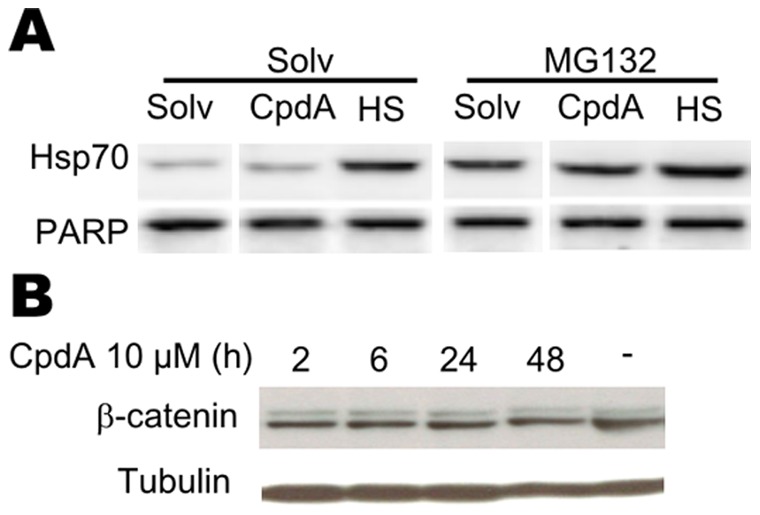
Compound A does not affect proteasomal degradation or translation.(A) A549 cells were preinduced with Solv or MG132 (5µM) for 1.5 h. Subsequently, cells were stimulated with Solv or CpdA (10µM) for 6h or subjected to the following temperature protocol : 2 hours at 43°C followed by 2 hours at 37°C (HS+Rec), as indicated. Total cell protein extracts were subjected to Western blot analysis detecting inducible Hsp70. Detection of PARP served as a loading control. The displayed bands were detected from one single membrane. (B) A549 cells were starved for 48h in 0% DMEM, after which these cells were treated with solvent for 48h or Compound A (CpdA) (10µM) for 2h, 6h, 24h or 48h. Total cell protein extracts were subjected to Western blot analysis detecting β-catenin. Tubulin detection served as a loading control.